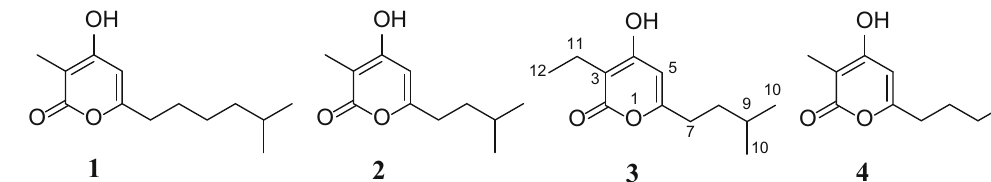
Fig. 1 Chemical structures of compounds 1 – 4